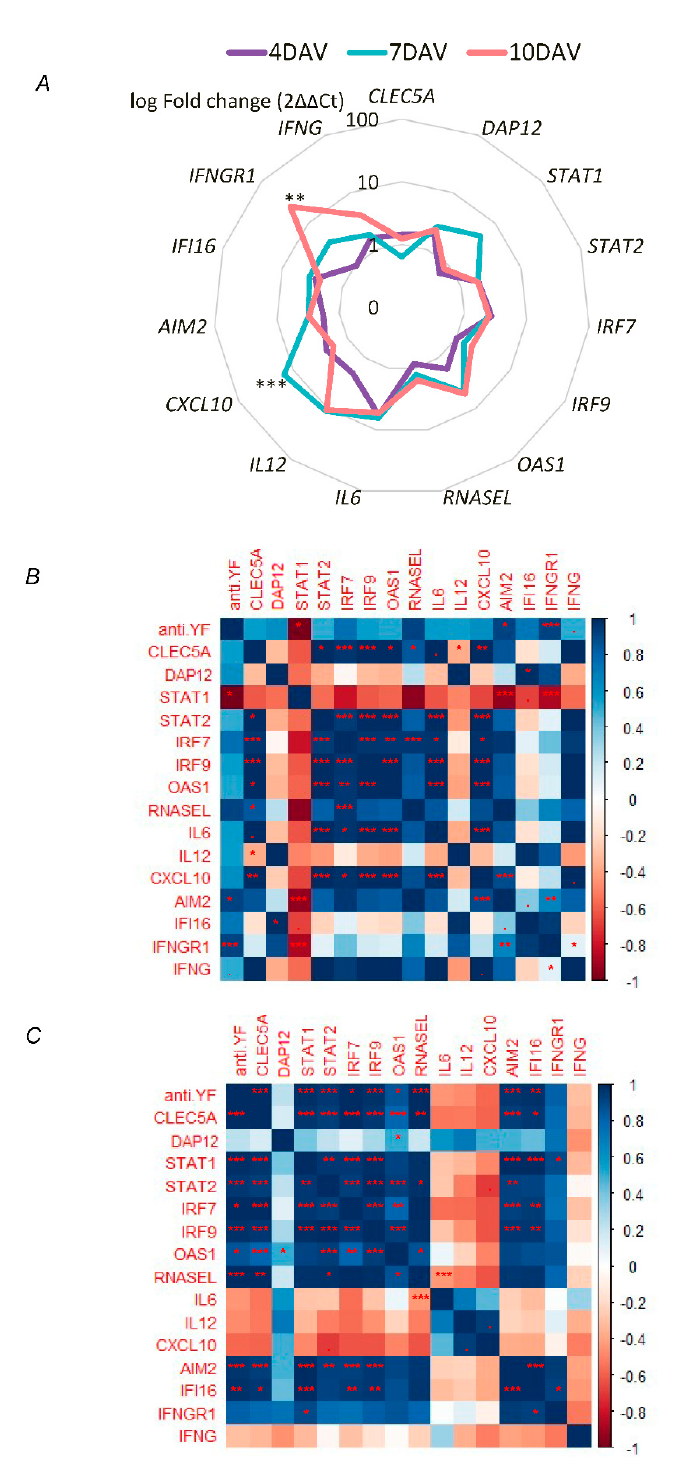
Figure 2. Gene expression profile of the early responses in first time YF17DD-vaccinated volunteers ( n = 15). ( A ) Radar chart representing the average log10 fold change (2 ∆∆ Ct) of each gene and day after vaccination (DAV). Mean 2 ∆∆ Ct values of CLEC5A, DAP12, STAT1, STAT2, IRF7, IRF9, OAS1, RNASEL, IL6, IL12, CXCL10, NOS1, AIM2, IFI16, IFNGR1, and IFNG clustered by 4 DAV (red), 7 DAV (yellow), and 10 DAV (blue). Fold change (2 ∆∆ Ct) was compared between DAV by Kruskall–Wallis test with Dunn’s post-test using the GraphPad Prism 5 software. The heatmaps represent the correlation R values according to the Z score for 2 ∆∆ Ct values of genes analyzed and anti-YF antibody production at ( B ) 7 DAV, and ( C ) 10 DAV. Spearman correlation and heatmaps by library “corrplor” from R-project. p value is represented as p < 0.1, * p < 0.05, ** p < 0.01, *** p <